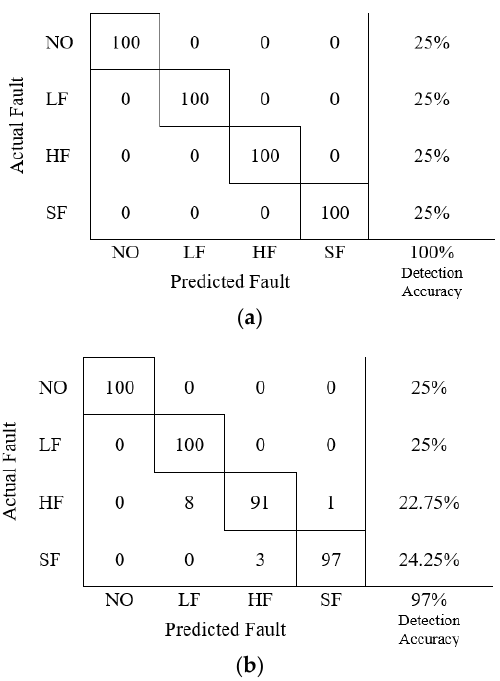
Figure 6. Output confusion matrix for ( a ) KNN and ( b ) LDR.